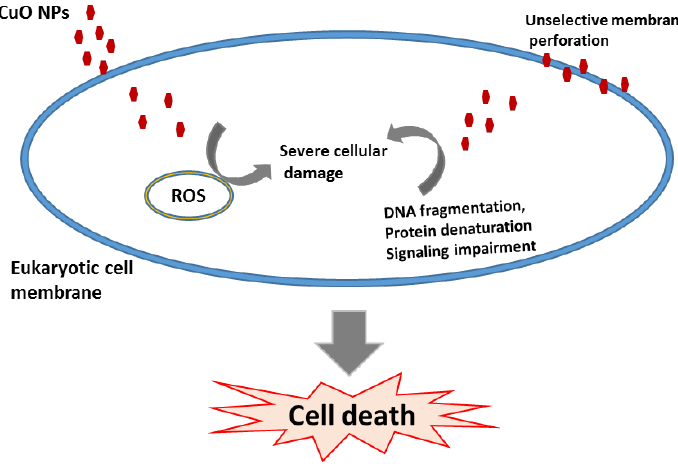
Figure 2. Toxicity mechanism of CuO nanoparticles in eukaryotic cells.